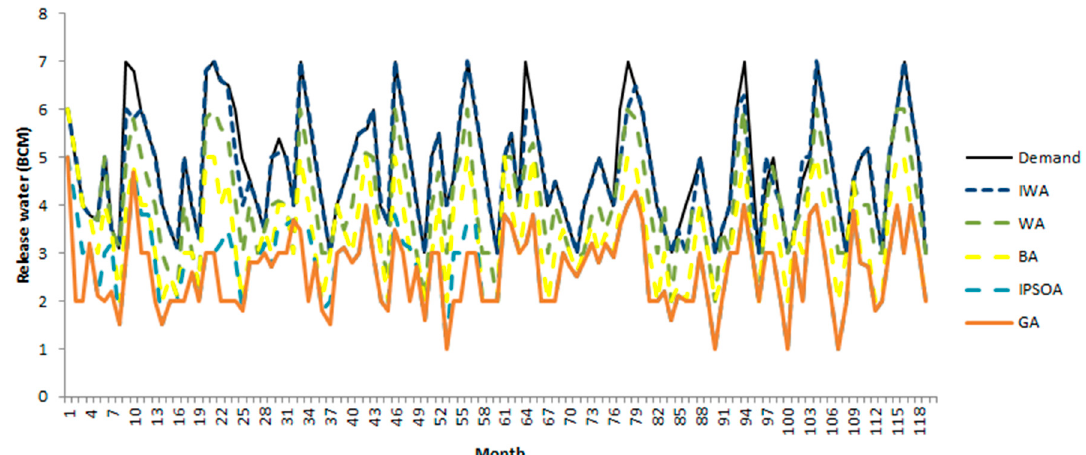
Figure 9. Released water for low inflow.